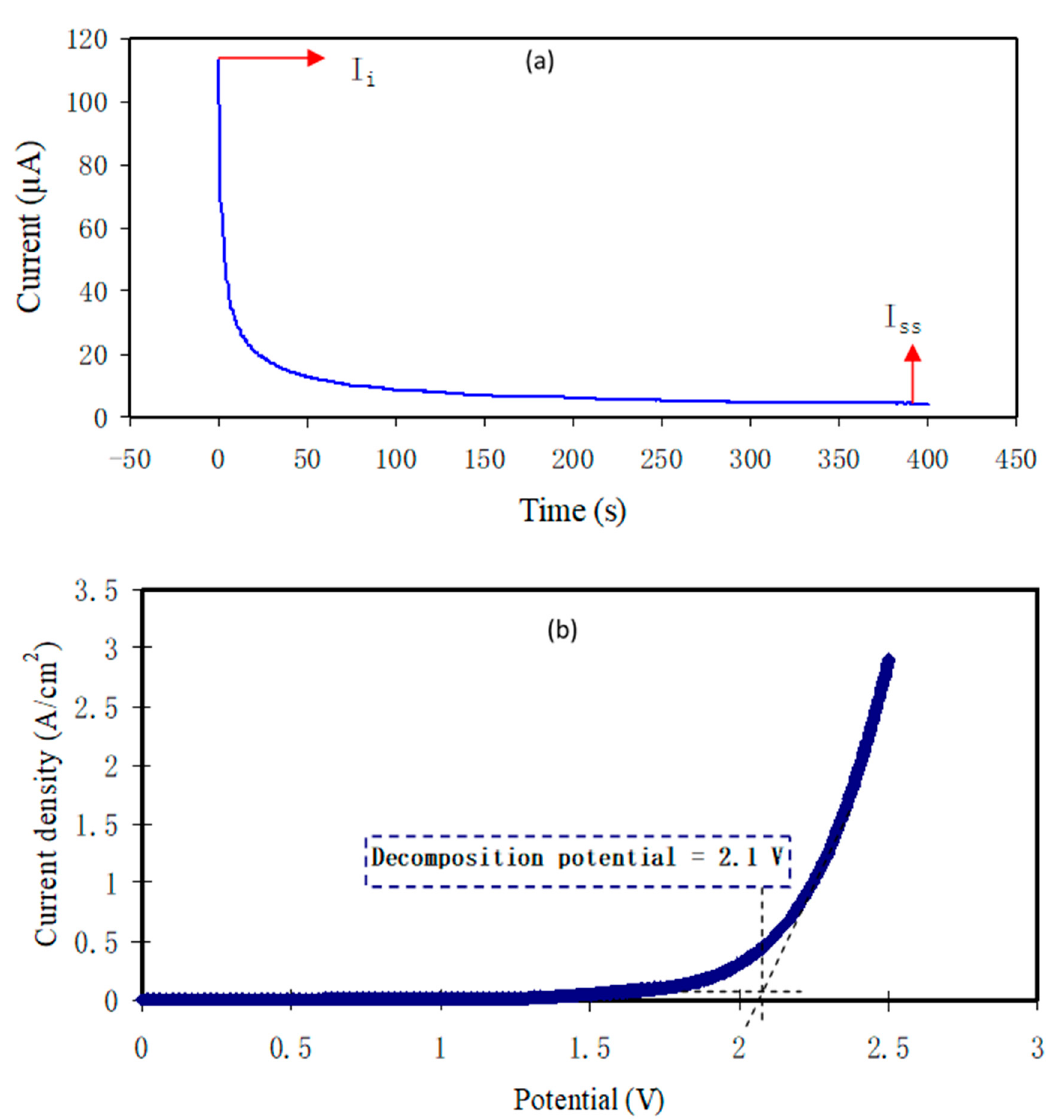
Figure 6. ( a ) Polarization current versus time for the PNCG-4 electrolyte and ( b )linear sweep voltammetry (LSV) for the PNCG-4 film of PCE.